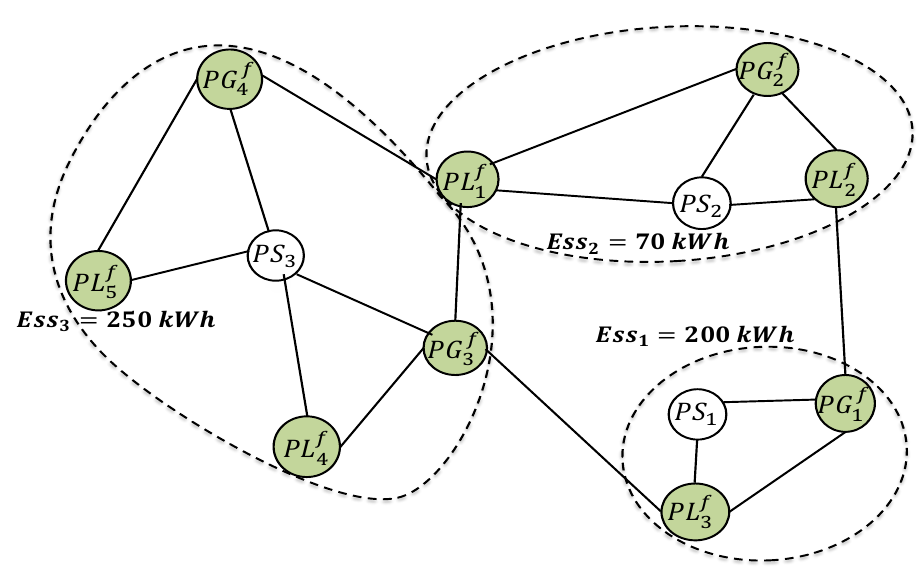
Figure 26. Third possible